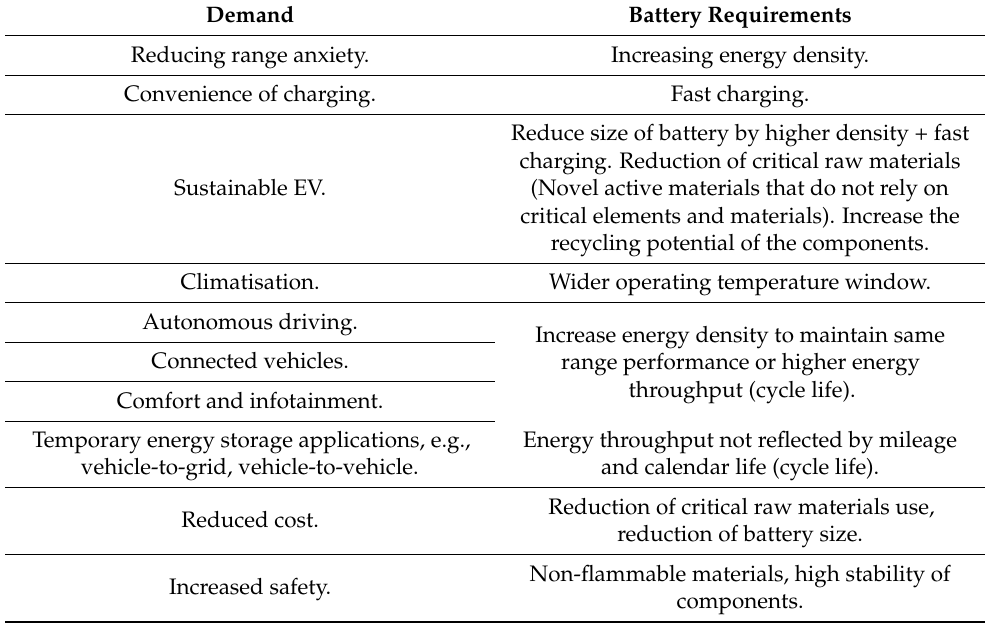
Table 1. End-user needs